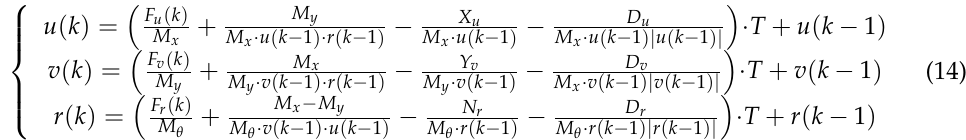
Figure 3. Nonlinear model predictive controller framework.